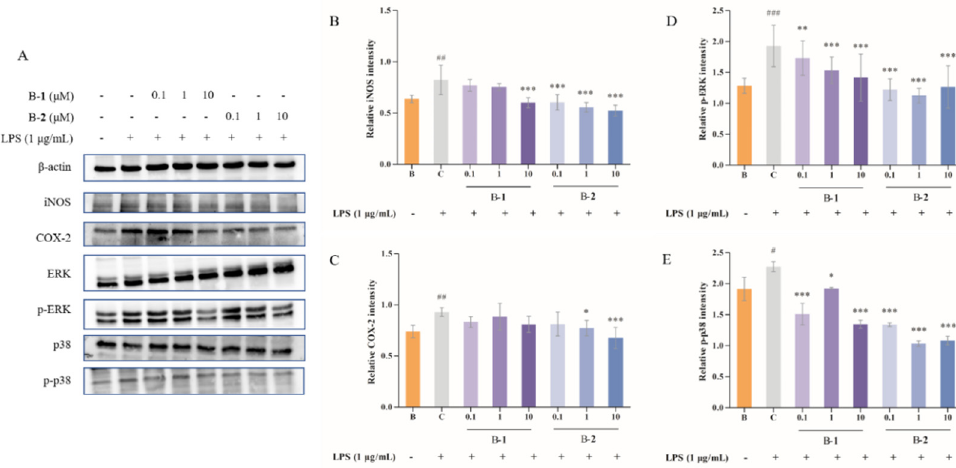
Figure 3. ( A ) Immunoblotting results of iNOS, COX-2, ERK, p-ERK, p38 and p-p38. ( B ) iNOS production of BV-2 cell treated by benzaldehydes 1 – 2 . ( C ) COX-2 production of BV-2 cell treated by benzaldehydes 1 – 2 . ( D ) p-pERK production of BV-2 cell treated by benzaldehydes 1 – 2 . ( E ) p-p38 production of BV-2 cell treated by benzaldehydes 1 – 2 . Cell lysates, antibodies against iNOS, COX-2, ERK, p-ERK, p38 and p-p38, were used to conduct Western blot analysis. β -actin was used as an internal control. Data are expressed as the means ± SD ( n = 3). # p < 0.05, ## p < 0.01, and ### p < 0.001 vs. normal control group, * p < 0.05, ** p < 0.01, and *** p < 0.001 vs. LPS induced group.